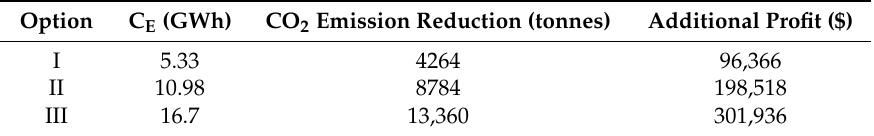
Figure 10. Economic efficiency optimization parameter—higher price for the energy included. Table 10. Reduction of CO 2 emission and additional profit for a 10-year period.